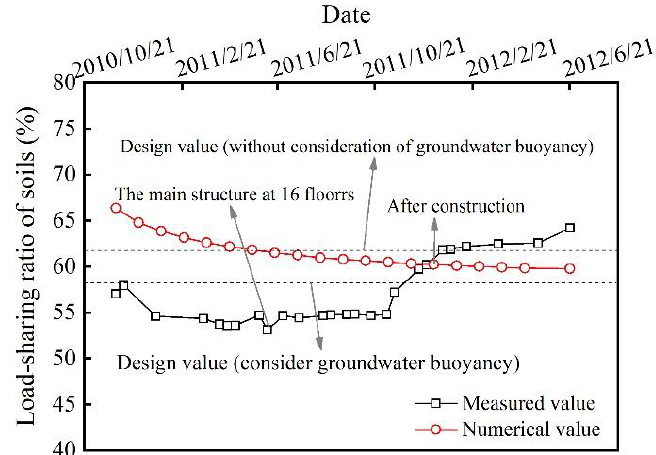
Figure 24. Curve of load-sharing ratio of soil variation with time .